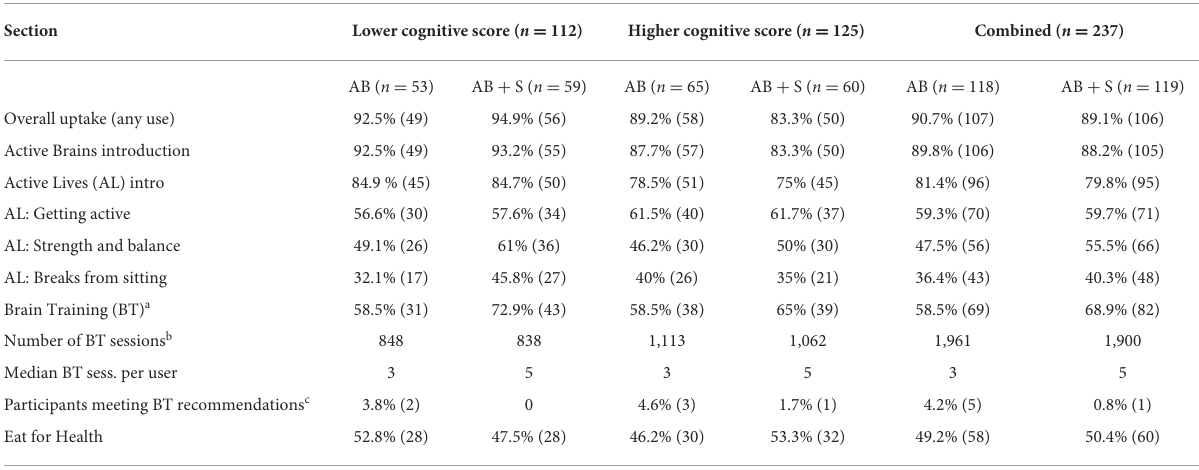
TABLE 3 Usage of Active Brains components by trial and trial